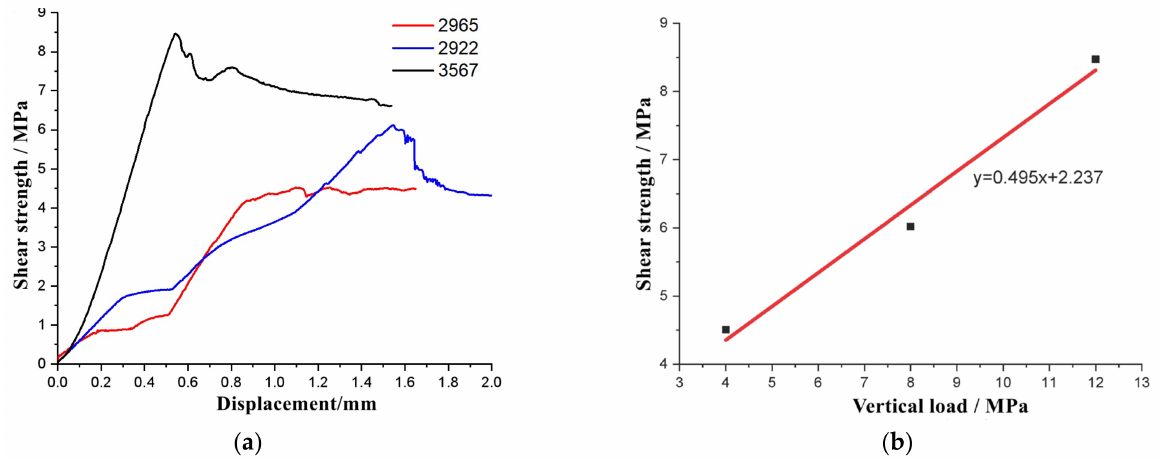
Figure 7. Shear parameter of the Salt-Shale samples: ( a ) Shear resistance curves, ( b ) Strength fitting